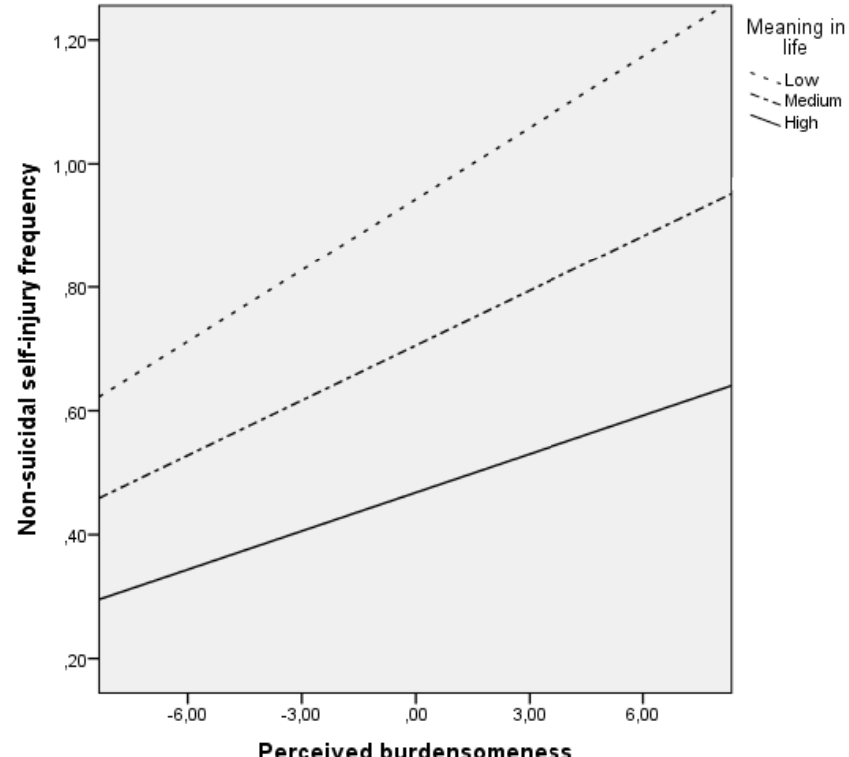
Figure 2. Meaning in life moderates the association between perceived burdensomeness and frequency of non-suicidal self-injury.